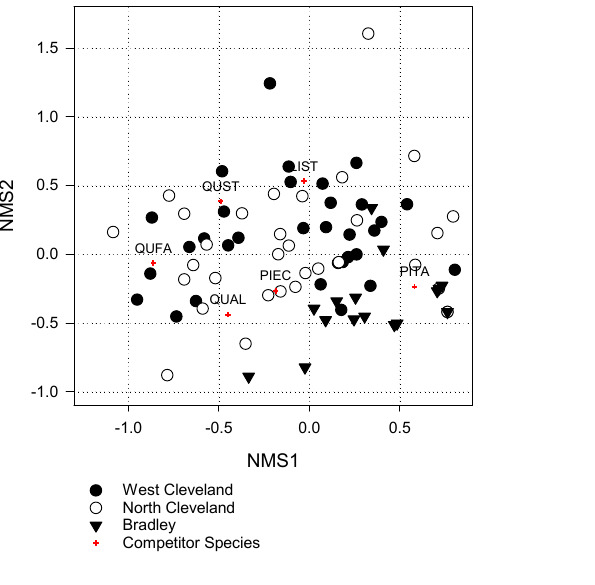
Figure 1. Mean importance value (%) of the five most abundant competitor species in the neigh- borhoods of shortleaf ( Pinus echinata ) and loblolly pine ( Pinus taeda ) across three mature, natural- origin, pine–hardwood stands in southeastern Arkansas (separated by dashed line).